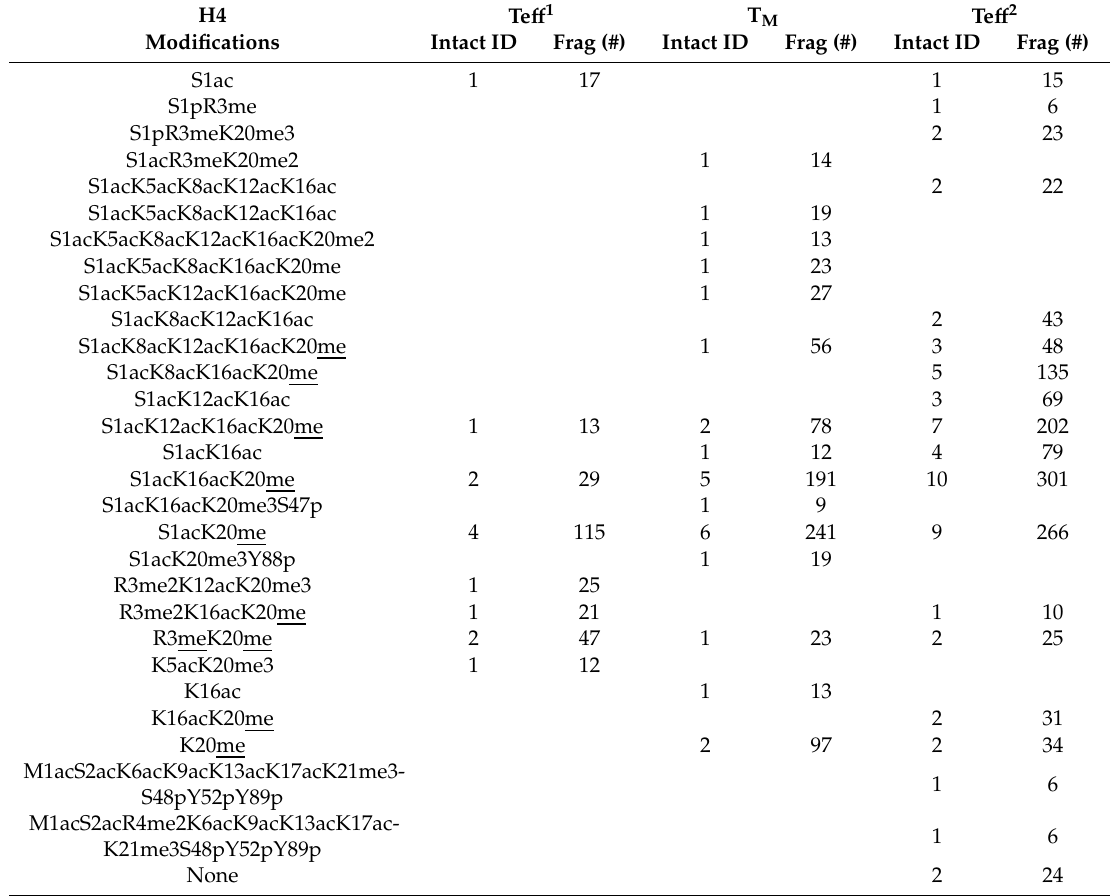
Table 5. H4 modifications from Te ff 1 , T M , and Te ff 2 after influenza